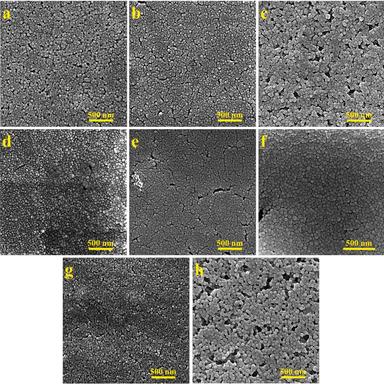
FESEM images for multi-functionalized copolymer nanoparticles of (a) PMMA, (b) PMMA-PBA, (c) PMMA-PCOOH, (d) PMMA-PHEMA, (e) PMMA-PGMA, (f) PMMA-PDMAEMA, (g) PMMA-PAAm, and (h) PMMA-PMAAm.